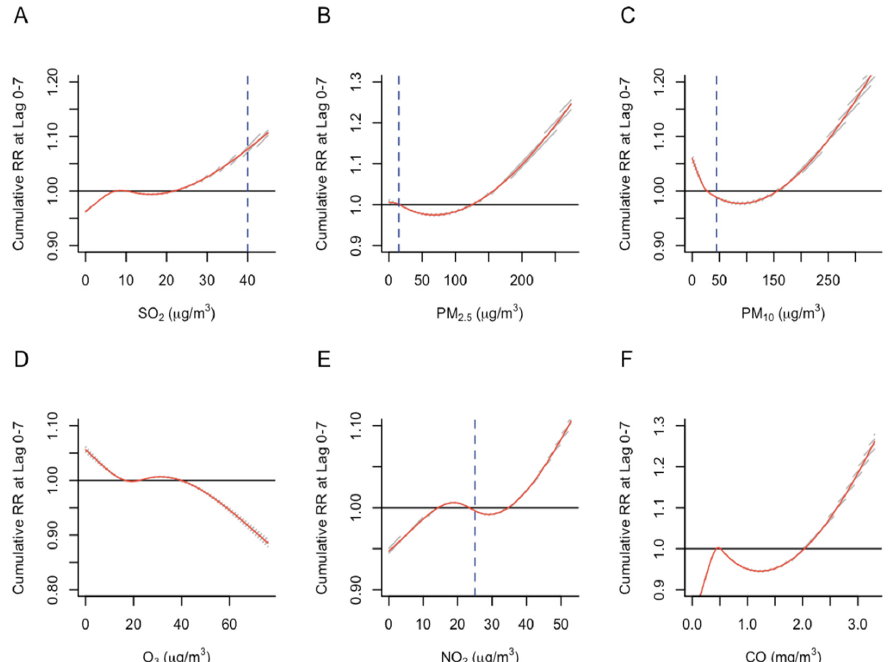
Figure 1. Association between air pollutant levels and cumulative relative risk (RR) of emergency admissions. ( A ) SO 2 levels and RR; ( B ) PM 2.5 levels and RR; ( C ) PM 10 levels and RR; ( D ) O 3 levels and RR; ( E ) NO 2 levels and RR; ( F ) CO levels and RR. The solid red line represents the modeled cumulative risk. The shaded areas represent the 95% confidence intervals. The horizontal solid black line represents the reference value. The vertical blue dashed line indicates the air pollutant level recommended by WHO air quality guidelines. There are no vertical dashed lines for Figure 1D and Figure 1F because the maximum values observed over the study period were much lower than the WHO guideline values for ozone (100 μ g/m 3 ) and carbon monoxide (4 mg/m 3 ).